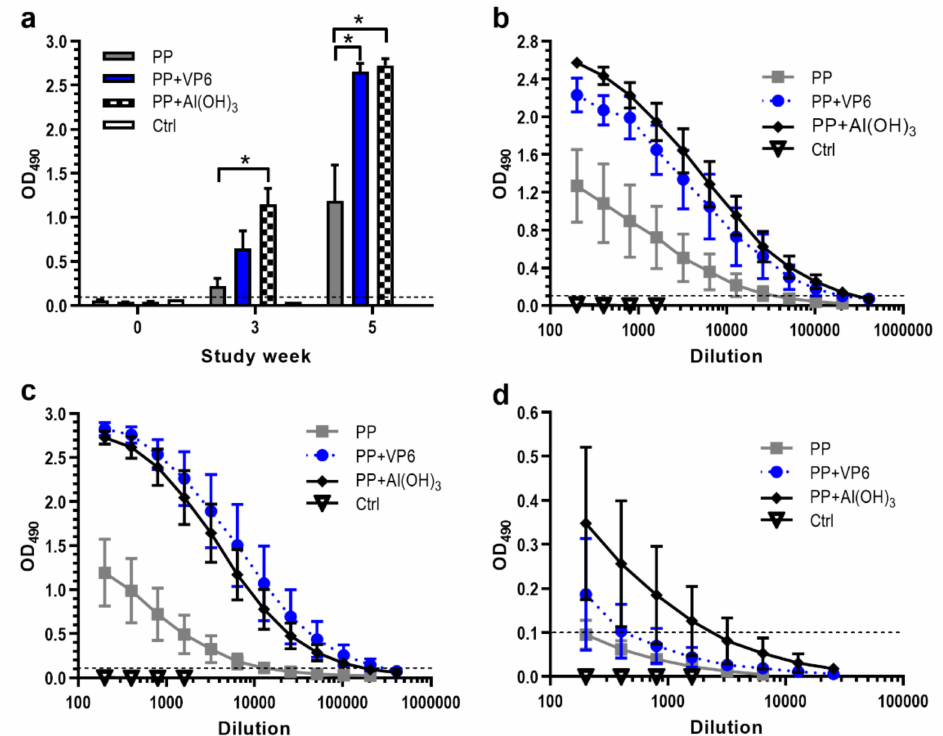
Figure 2. Development of serum antibody responses against norovirus P particles (PP) following immunization with PP alone or formulated with VP6 or Al(OH) 3 . Control (Ctrl) received no immunogen. ( a ) Kinetics of total IgG antibodies following immunizations at study weeks 0 and 3. Group mean OD 490 values with standard errors of the means of 1:200 diluted sera at indicated study weeks are shown. * indicates statistically significant ( p > 0.05) di ff erences between the groups. Endpoint titration curves of serum IgG ( b ) IgG1 ( c ) and IgG2a ( d ) antibodies in termination sera at study week 5. Shown are mean titration curves with standard errors of the means of the experimental groups. Horizontal dashed lines indicate the cut-o ff level (OD 490 ≥